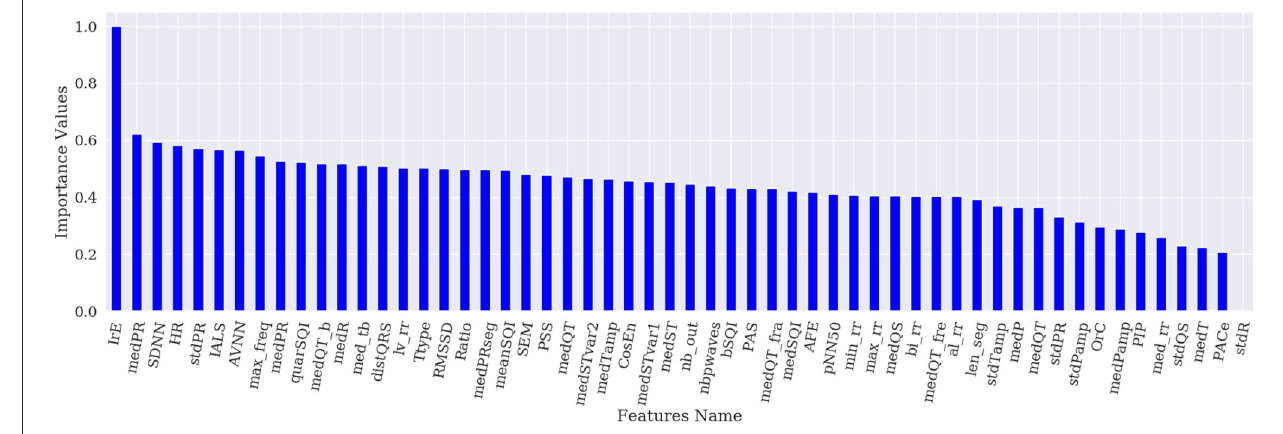
FIGURE 1 | Feature importance based on LR.